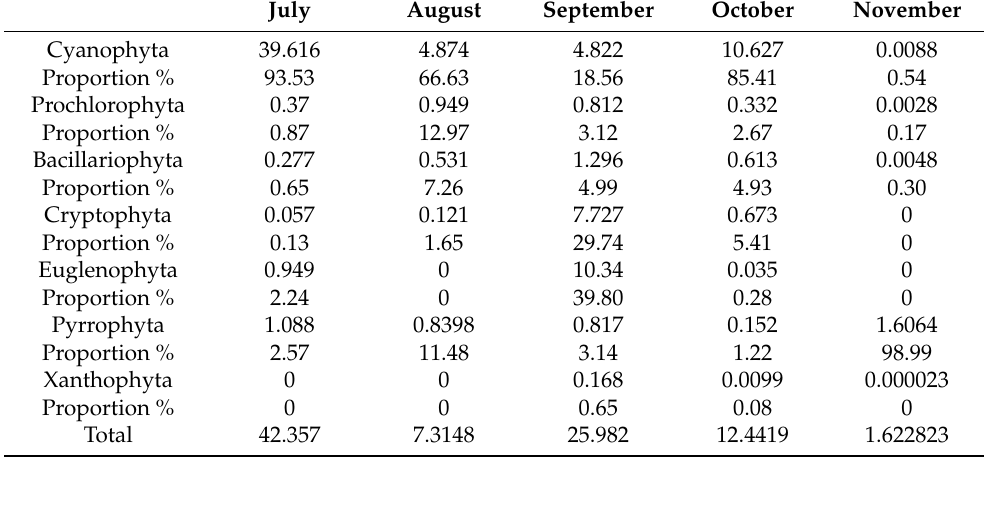
Table 6. Phytoplankton biomasses (mg/L) and proportions in the water around the artificial reefs.